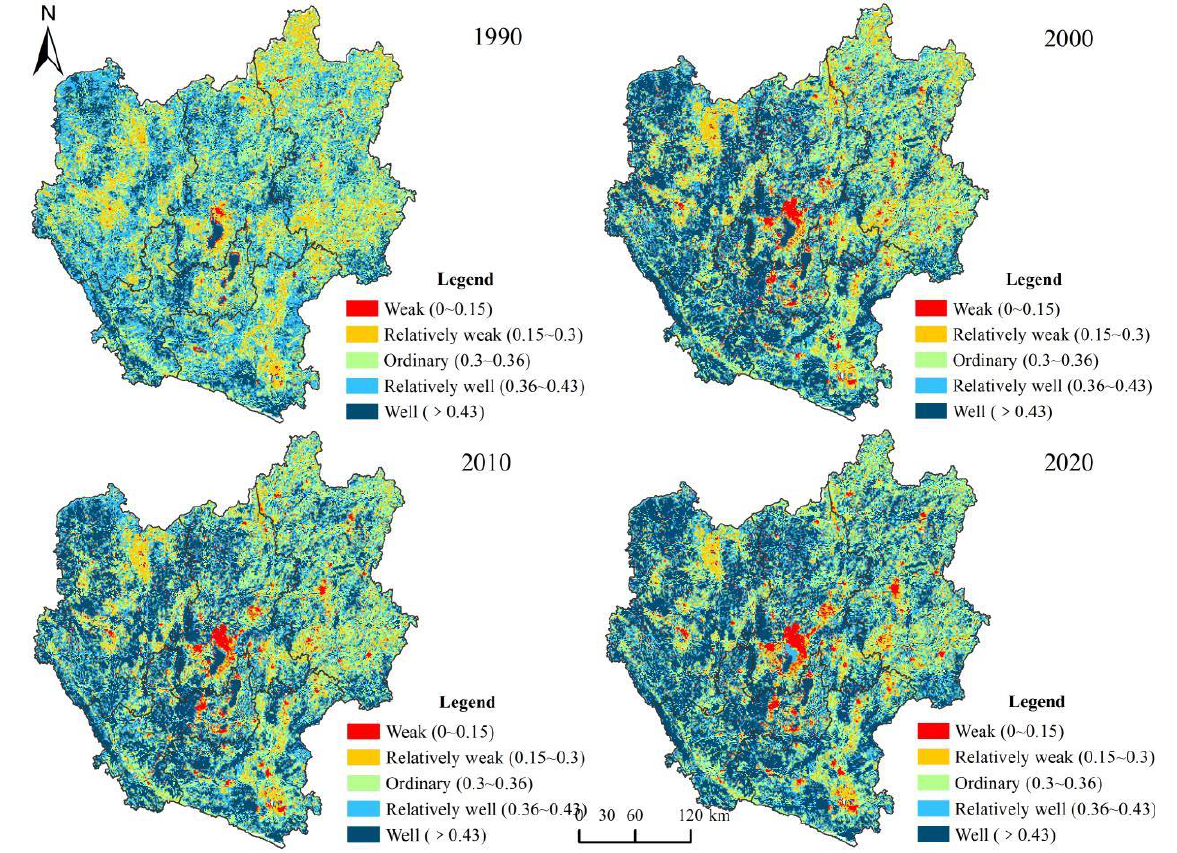
Figure 5. Spatial distribution of EHI by class in central Yunnan urban agglomeration, 1990 – 2020.